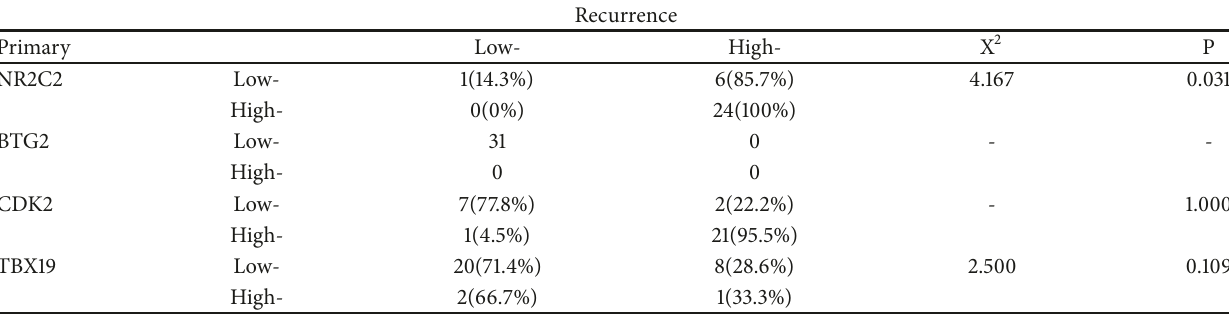
Table 3: The paired recurrent